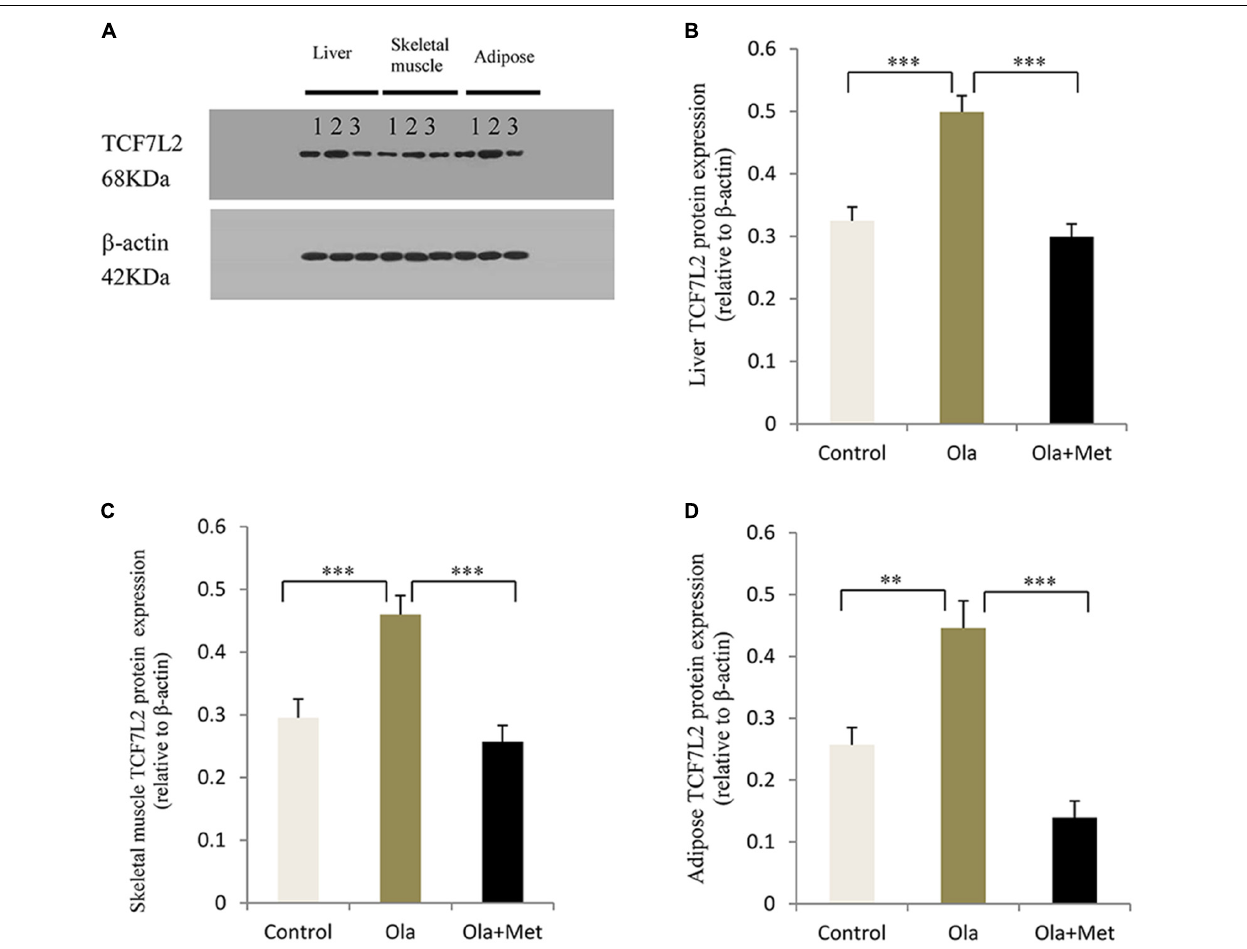
FIGURE 4 | Effect of olanzapine on TCF7L2 protein expression in liver, skeletal muscle, and adipose tissue in C57BL/6 mice. C57BL/6 mice were treated with olanzapine (4 mg/kg/day, Ola), olanzapine (4 mg/kg/day, Ola) + metformin (150 mg/kg/day, Met), or saline for 8 weeks. (A) Protein expression level of TCF7L2 in liver, skeletal muscle, and adipose tissue of mice was measured via western blotting. Representative immunoblot images of TCF7L2 are shown. 1, 2, and 3 represents Control, Ola, and Ola + Met group, respectively. (B) Quantitative analysis was used to qualify the TCF7L2 protein expression level in liver. (C) Quantitative analysis was used to qualify the TCF7L2 protein expression level in skeletal muscle. (D) Quantitative analysis was used to qualify the TCF7L2 protein expression level in adipose tissue. n = 10 for each group. All of the results are expressed as the mean ± SEM. ∗∗ p < 0.01, ∗∗∗ p <